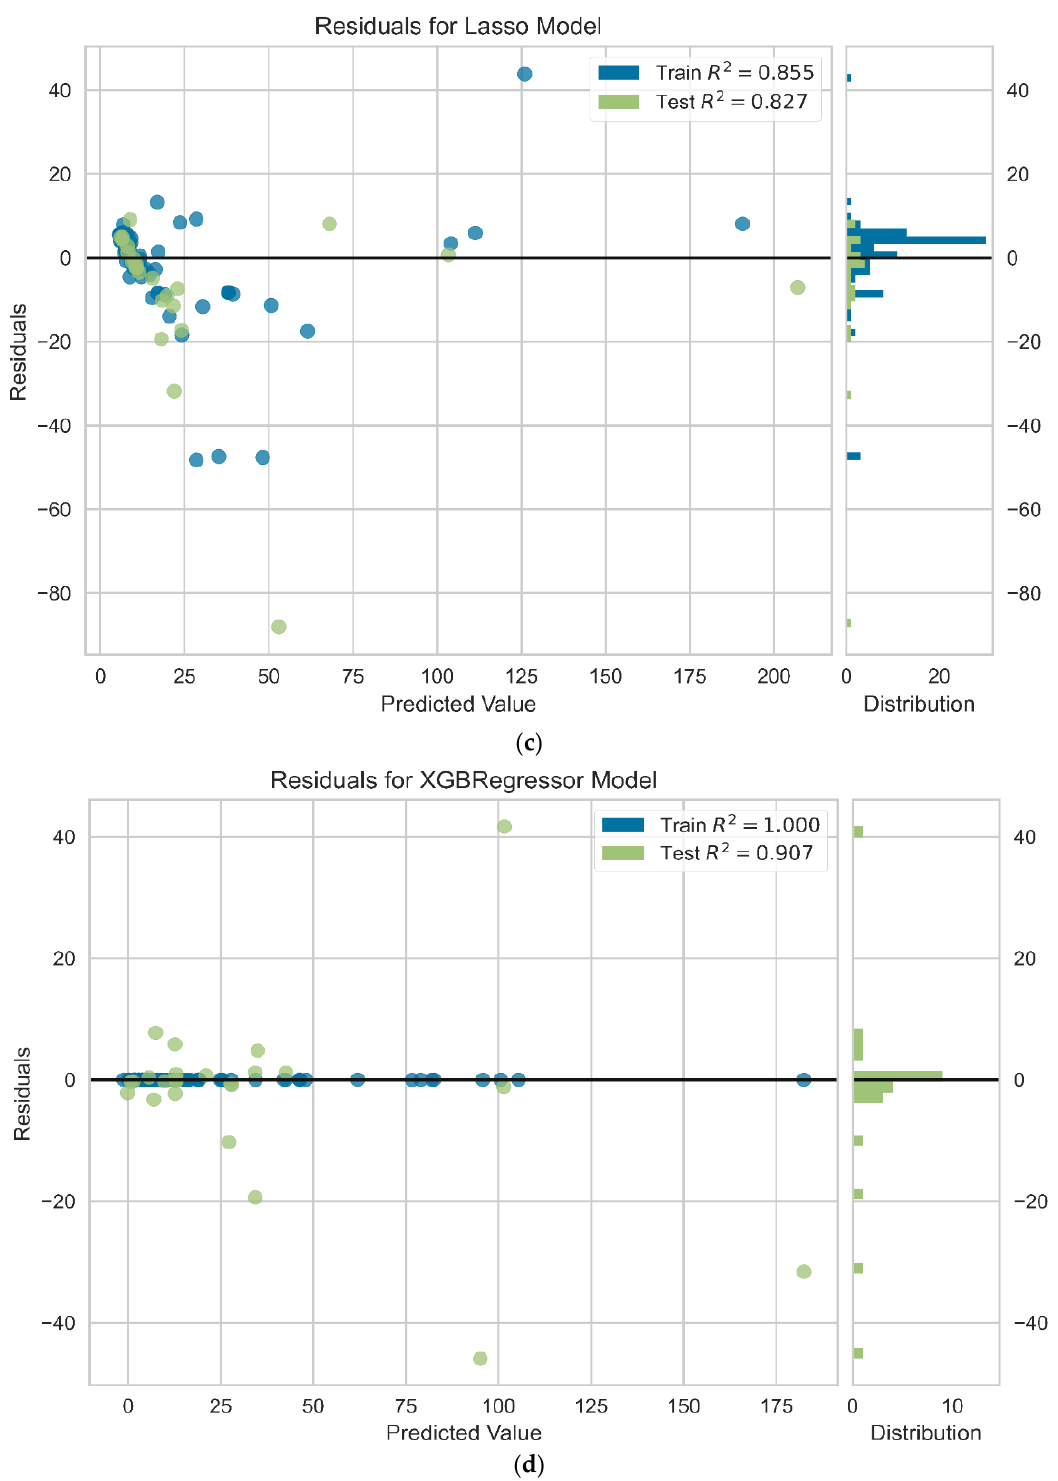
Figure 8. ( a – d ): Distributions of residuals in the training and testing sets.